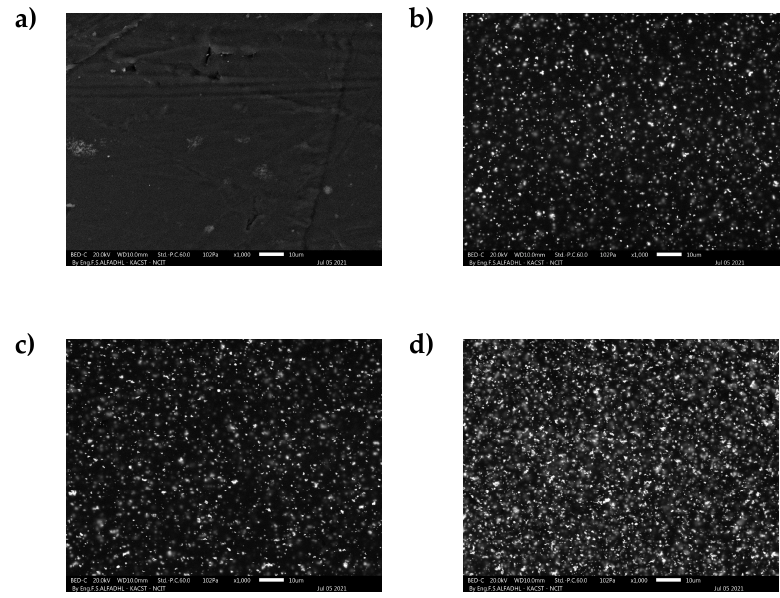
Figure 4. The surface morphology of LDPE nanocomposites ( a ) pure LDPE ( b ) 5 wt% Bi 2 O 3 ( c ) 10 wt% Bi 2 O 3 and ( d ) 15 wt% Bi 2 O 3 .